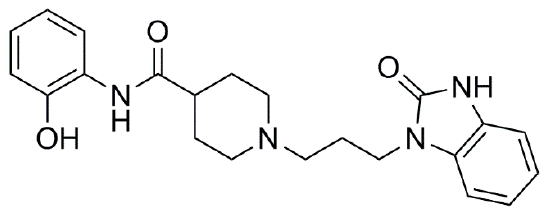
Figure 1. The virtual hit N -(2-hydroxyphenyl)-1-[3-(2-oxo-2,3-dihydro-1 H -benzimidazol-1-yl)propyl]piperidine-4-carboxamide (D2AAK4).